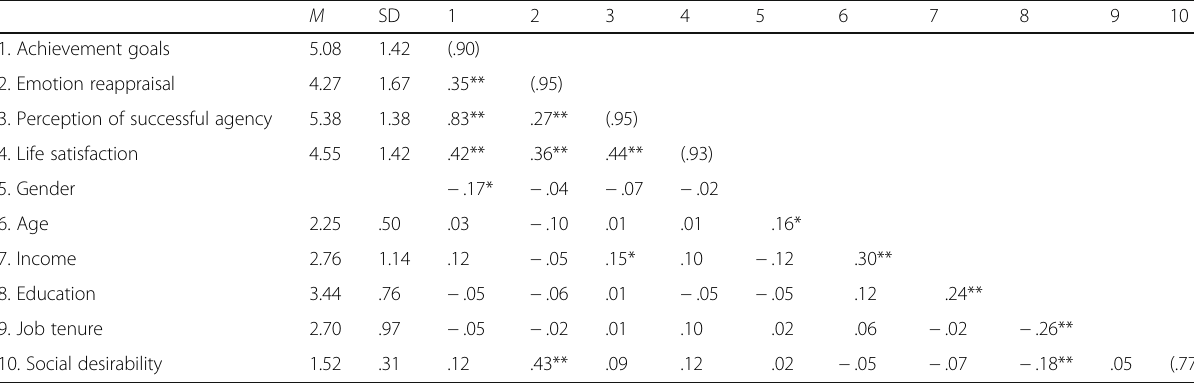
Table 2 Descriptive statistics, coefficient alphas, and zero-order correlations between variables M